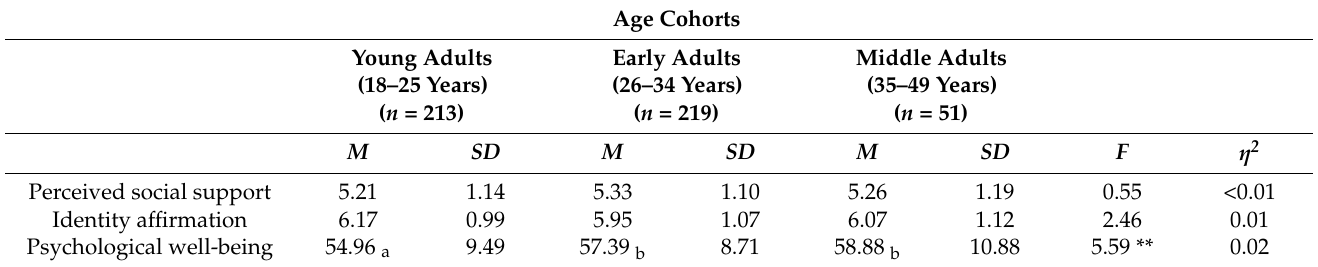
Table 4. Associations of perceived social support, identity affirmation, and psychological well-being with age groups.